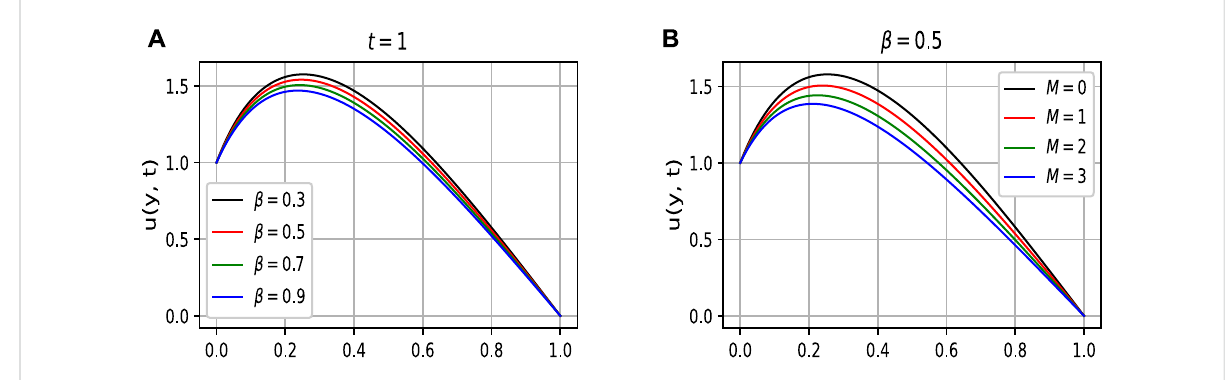
FIGURE 2 The behaviour of the boundary layer velocity as the parameters β and M